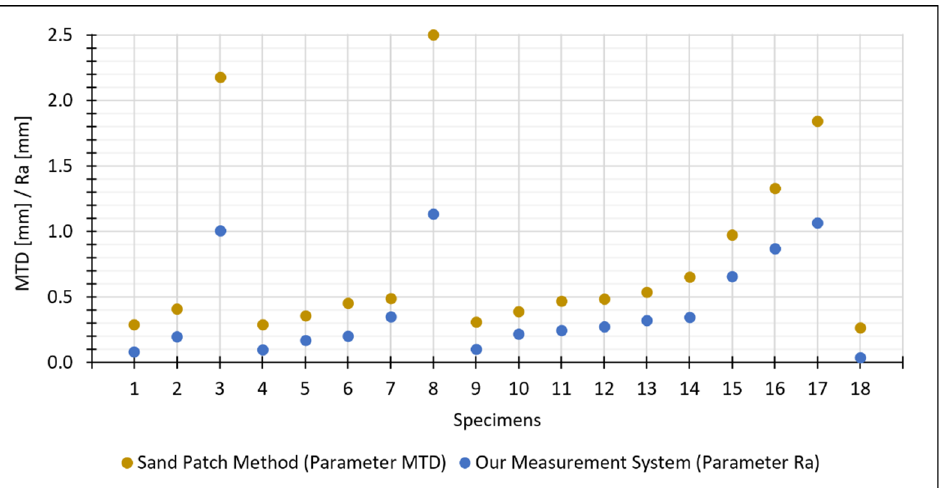
Figure 19. Comparison between R a estimated by our measurement system and the references values for MTD determined by the sand patch method. The values for the parameter (cid:1844) (cid:3028) estimated by our measurement system are lower than the reference values for the (cid:1839)(cid:1846)(cid:1830) parameter. However, that was to be expected: Alt- hough both parameters represent the mean distance of the actual surface to a reference plane, the two reference planes used by the two methods are different. To be specific, (cid:1844) (cid:3028) refers to the mean plane estimated through all points of the surface, while (cid:1839)(cid:1846)(cid:1830) refers to the plane placed onto the uppermost peaks (which leads in general to higher distances between the surface and the reference plane).